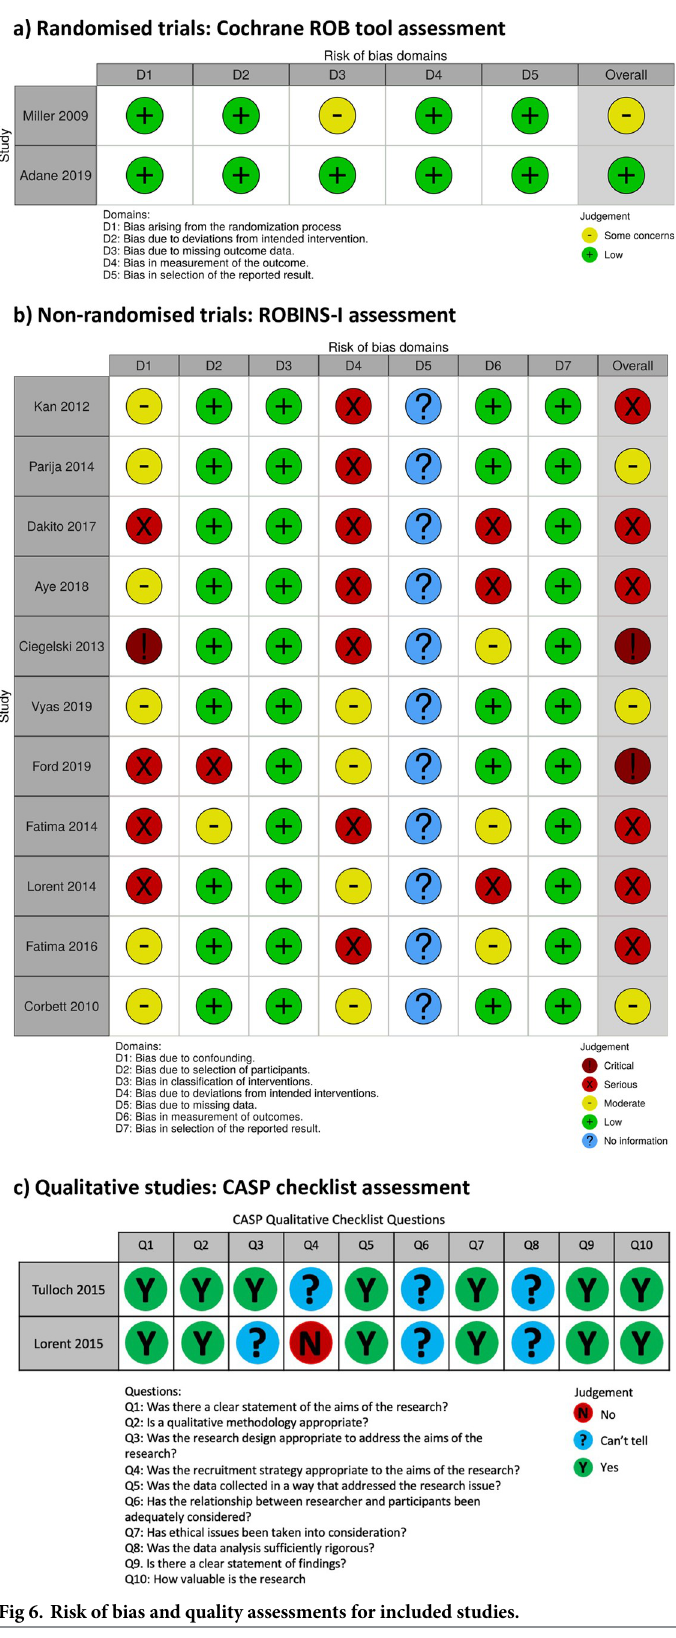
Fig 6. Risk of bias and quality assessments for included studies.